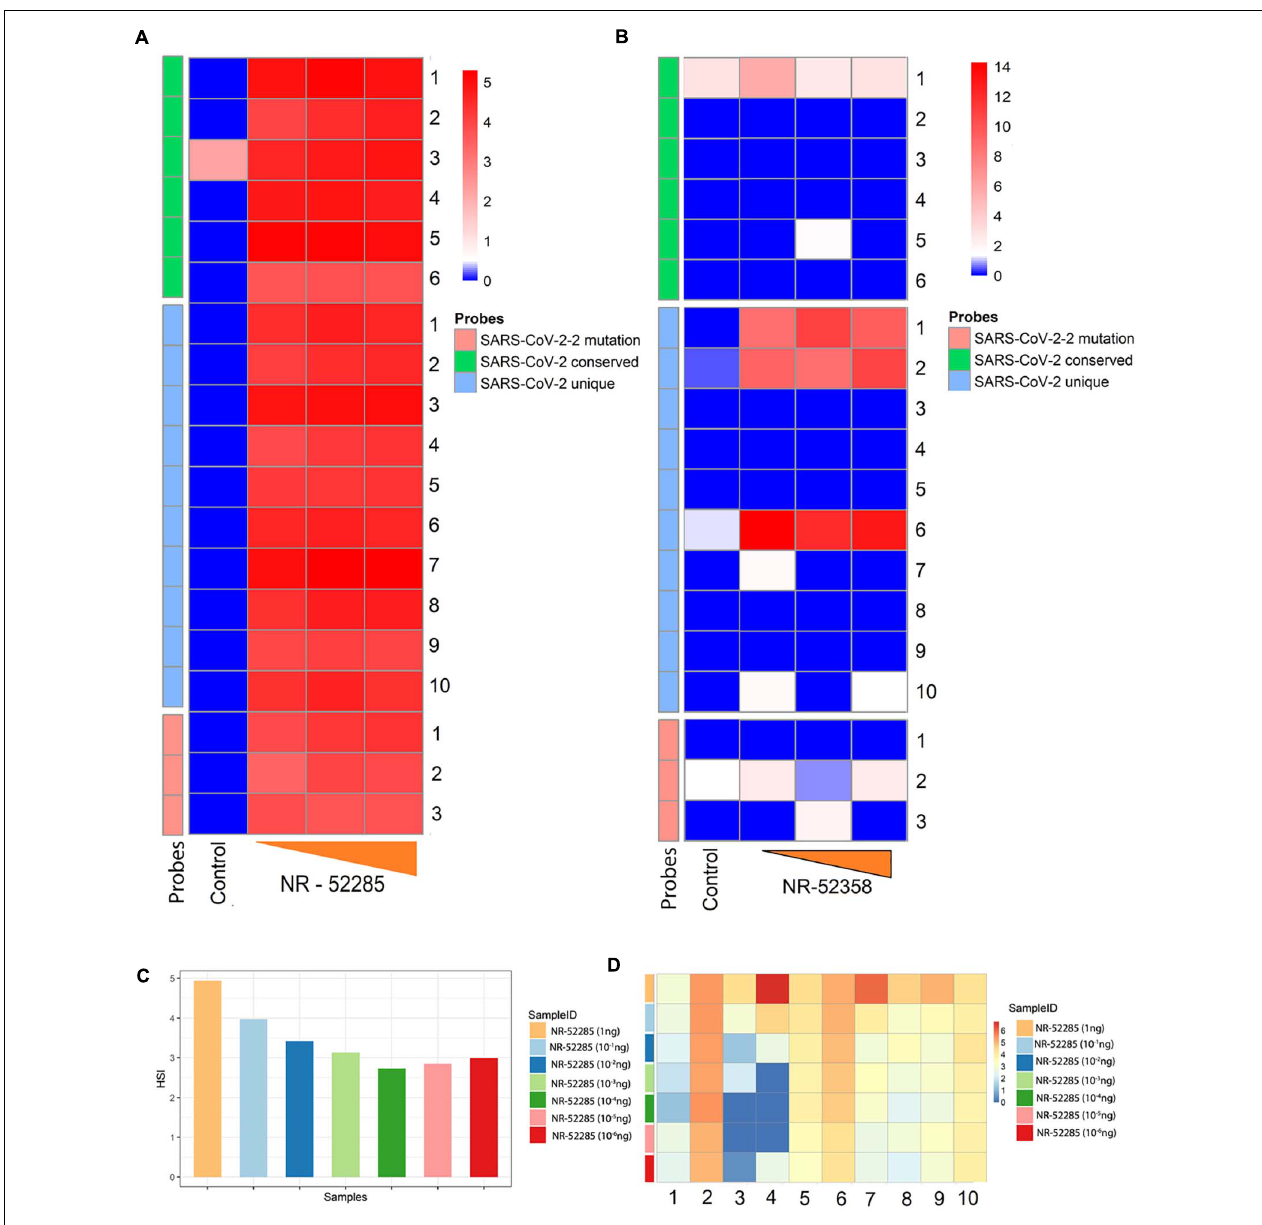
FIGURE 2 | Determining efficacy and sensitivity of new conserved, mutated and unique SARS-CoV-2 probes using Agilent V5 microarrays. (A) Heatmap of hybridization signal intensity (HSI) for SARS-CoV-2 conserved, unique, and mutated probes positively detected reference sample NR-52285 with increasing hybridization input (1.5, 7.5, and 15 ng). (B) Heatmap of HSI for SARS-CoV-2 conserved, unique, and mutated probes positively detected from synthetic RNA NR-52358 containing fragments of the SARS-CoV-2 genome with increasing hybridization input (1, 5, and 10 ng). (C) Bar plot showing average HSI of all SARS-CoV-2 probes, including conserved, unique, and probes within the region susceptible to mutations, for positive control NR-52285 samples of decreasing hybridization inputs. (D) Heatmap of the HSI of individual SARS-CoV-2 unique probes for each sample of NR-52285 with increasing hybridization input (1-10 − 6 ng of